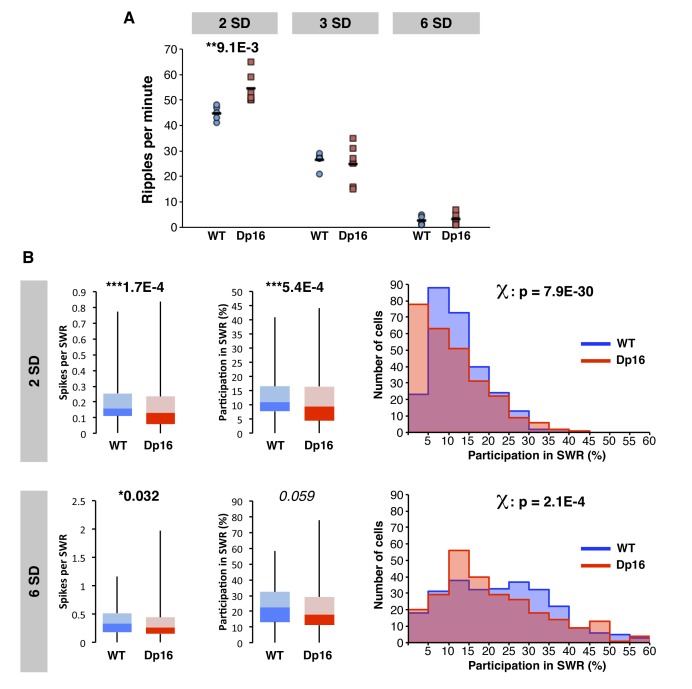
Decreased activity of CA1 pyramidal cells during ripple events in Dp(16)1Yey mice is not related to ripple amplitude.(A) Compared to the standard detection threshold (commonly placed at 3 SD), using a more permissive threshold (2 SD) led to a larger number of ripples detected in both WT and Dp16 mice. The frequency of occurrence of ripple events was significantly higher in Dp16 than their WT littermates. On the contrary, using a more restrictive threshold (6 SD) decreased the amount of ripples detected in both genotypes to similar low levels. (B) The number of spikes per cell per ripple and the participation of individual cells in ripple events were significantly lower in CA1 pyramidal cells of Dp16 mice even when ripple events were detected using a more permissive threshold (2 SD). A similar effect was seen using a more restrictive threshold (6 SD), even though the decrease in participation rate in Dp16 mice did not reach the significance level. Using either the more restrictive or more permissive threshold for the detection of ripples, the proportion of cells plotted as a function of their participation rate in sharp-wave ripples confirmed a significant shift toward lower participation rates in Dp16 mice. Statistical significance was assessed using one-way ANOVA (A) or Mann-Whitney U-test and chi square text (B) with significance set at (*) p<0.05, (**) p<0.01 and (***) p<0.001.